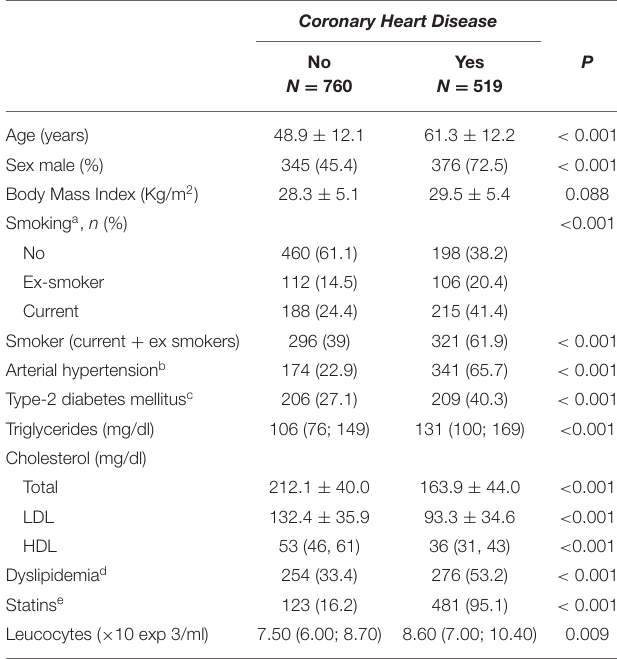
TABLE 1 | Cardiovascular risk factors among patients and